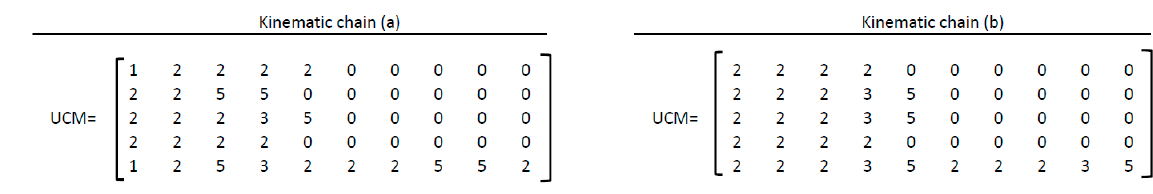
Figure 10. Unified chain matrix for the kinematic chain in Figure 9a,b. 4.2. Example Two: Eight-Link KCs of One DOF with Two Multiple